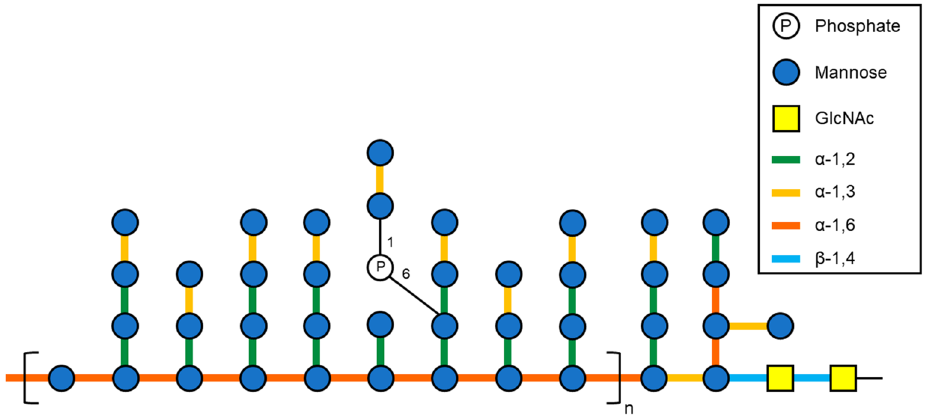
Figure 1. Schematic of the yeast mannan (YM) structure. YM includes a linear α-1, 6-mannoside backbone branched with α-1, 2-mannoside and α-1, 3-mannoside bonds in the form of mono-, di-, tri-, and